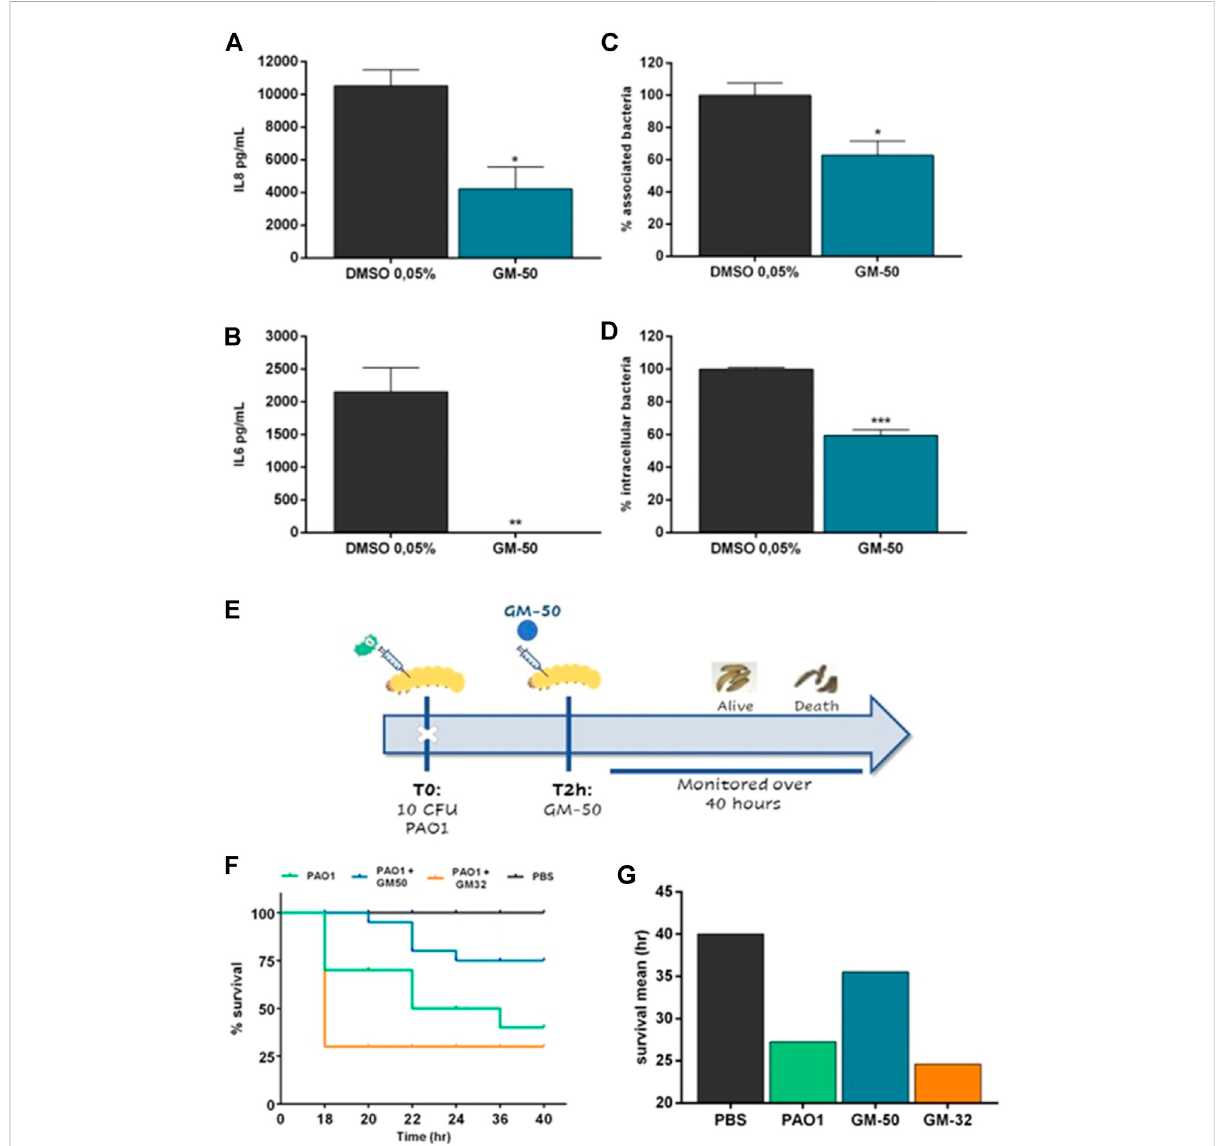
FIGURE 5 EffectofGM-50onPA01-epithelialcellsinteractionandPAO1 G.mellonellain-vivo infectionmodel.PAO1(10 6 CFU/ml)wasculturedinLBwith GM-50 (100 µM) or DMSO 0.05% (vehicle) for 24 h at 37 ° C and used to infect adherent A549 cells monolayers (MOI 1:20) for 2 h (A,B) Cells were washed, and cultured for 24 h in fresh DMEM containing gentamycin sulfate (200 μ g/ml). IL-8 and IL-6 were quanti fi ed by ELISA in conditioned media. (C) Cells were washed, collected, lysed, seeded on LB-agar plates, and incubated overnight at 37 ° C to enumerate total bacteria associated with A549 monolayers (internalized and adherent) expressed as CFU/cell. (D) Cells were washed and incubated in media containing gentamycin sulfate. After 2 h cells were washed, collected, lysed, and seeded on LB-agar plates to enumerate internalized bacteria, expressed as CFU/cell. Dataarerepresentedasmean±SEM, n =3experiments.* p < 0.05, ** p < 0.01,*** p < 0.001,**** p < 0.0001vs.PAO1withDMSO0.05%. (E) Schematic representation of the experimental design. G. mellonella larvae were infected with 10 CFU of PAO1. Two hrs later, larvae were injected into the right proleg with speci fi ed compounds and monitored for 40 h. (F) Kaplan-Meier survival curve of infected G. mellonella receiving no treatment, treatment with GM-50 or GM-32, a molecule devoid of activity on AHL-dependent QS (see Supplementary Material). * p < 0.05 vs. PAO1. (G) Average hrs of larvae survival